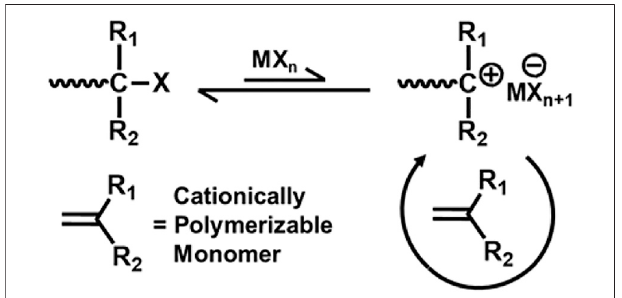
FIGURE 1 | General mechanism of controlled/living cationic